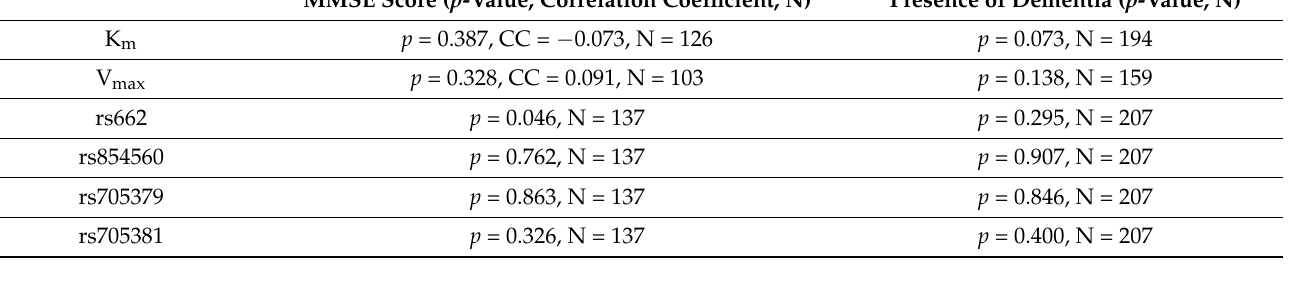
Table 6. Associations between dementia status and PON1 single-nucleotide polymorphisms (SNPs).